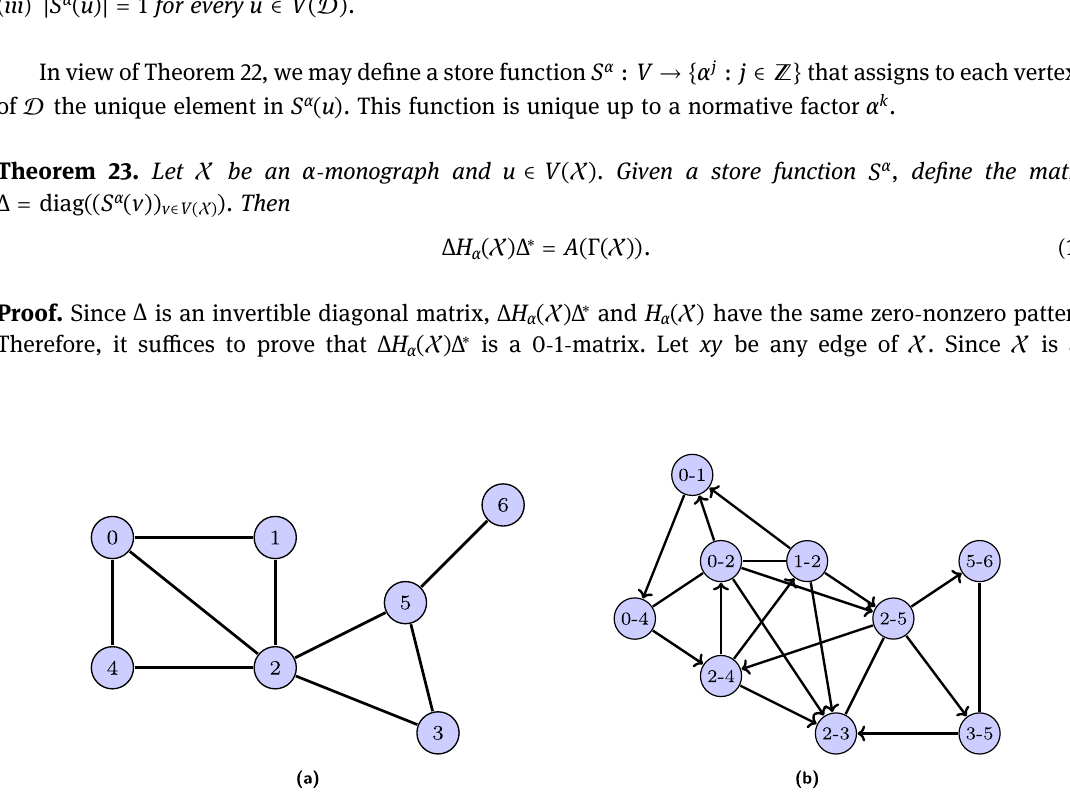
Figure 3: Mixed orientation of a line graph that is not a mixed line graph. ( a ) Root graph (cid:2) and ( b ) mixed orientation of ( ) (cid:2) L